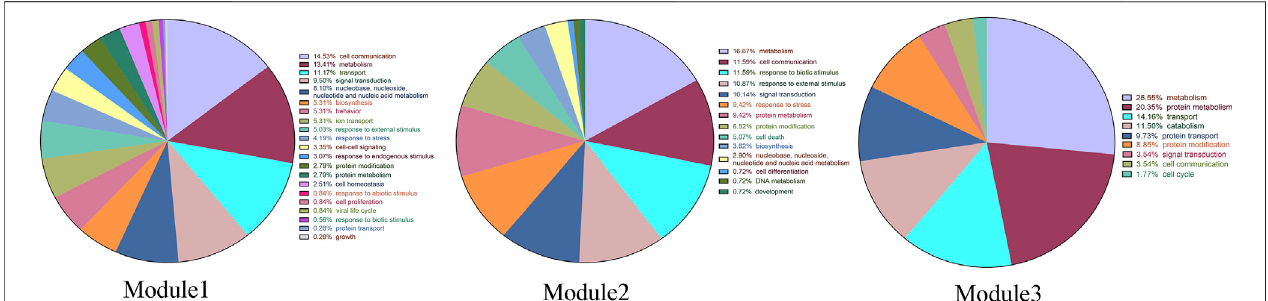
FIGURE 2 | The GO-BP classi fi cation chart of three